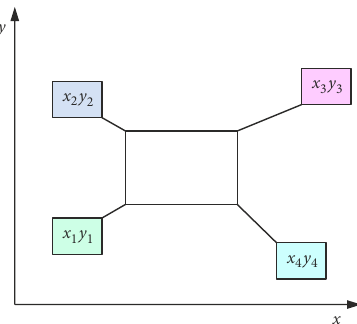
Figure 12. A real example of the use of the algorithm: iteration of tower crane selection